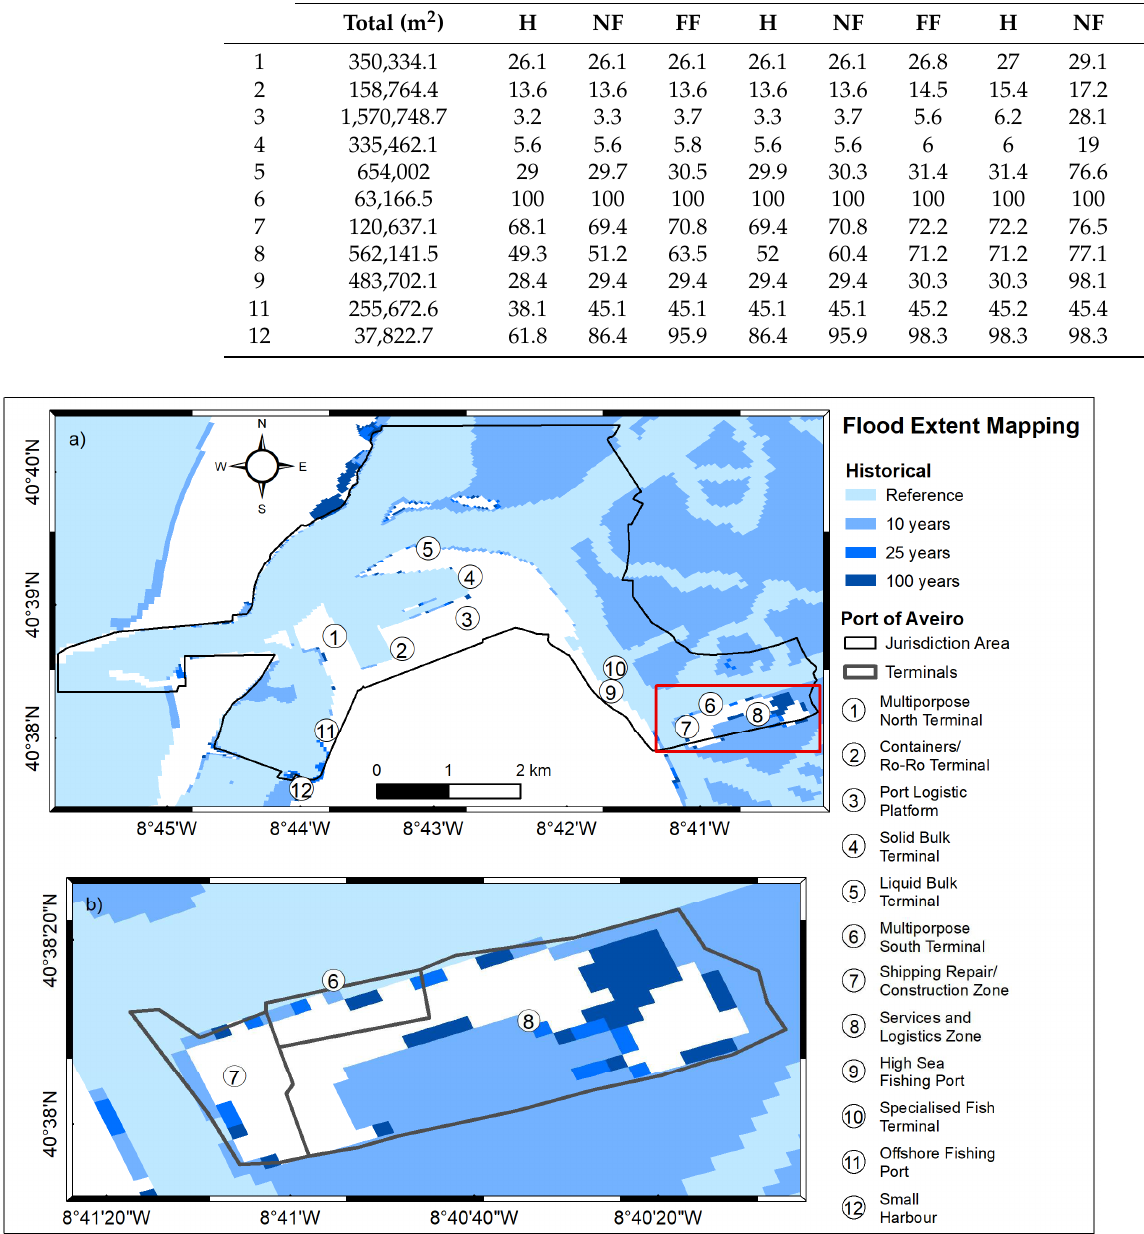
Figure 6. Flood extent mapping of the Aveiro Port’s terminals and zones (numbers 1–12) under its jurisdiction ( a ) (black line) and zoom of the most flooded area ( b ) (red line). Reference scenario under present climate and 10-, 25-, and 100-year return period are determined for the historical (1979–2005) climate